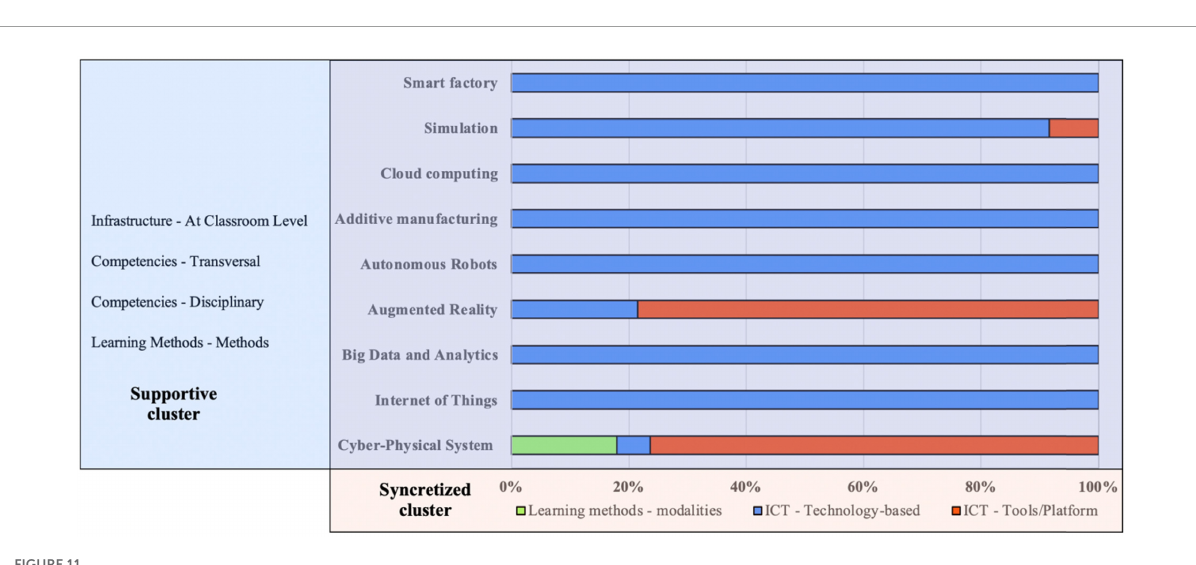
FIGURE11 Syncretized and supportive clusters, identified post bibliometric analysis, to map I.D. 4.0 requirements, to E.D. 4.0 core